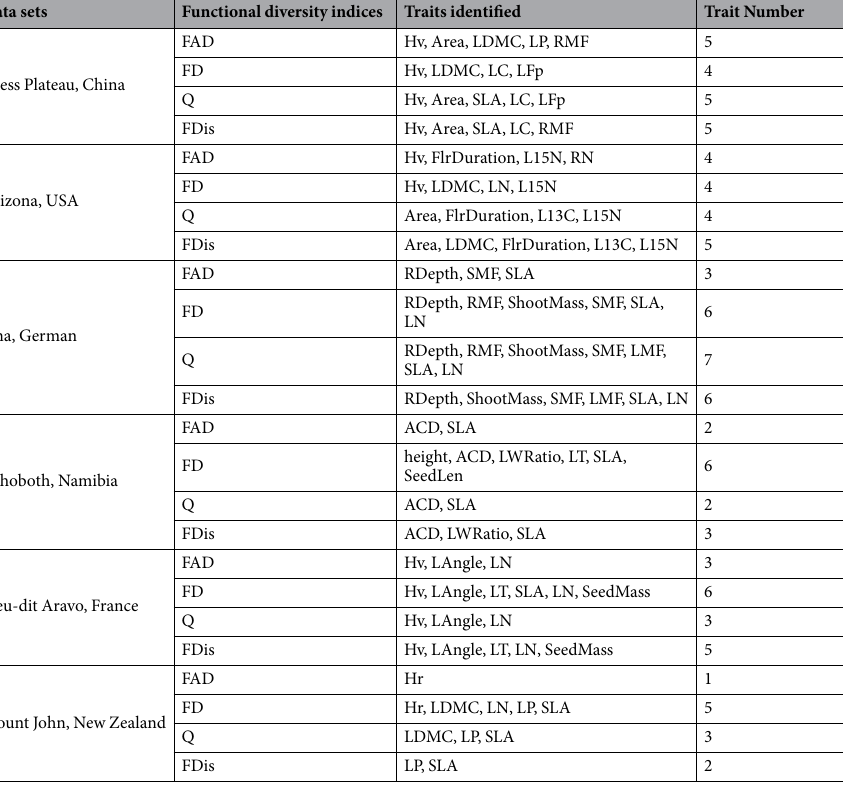
Table 2. The best subsets of traits determined by the complete search method. Functional diversity indices calculated using these traits had the association of the highest closeness with species richness. See the abbreviations for traits in the Table S2 in the Supplementary